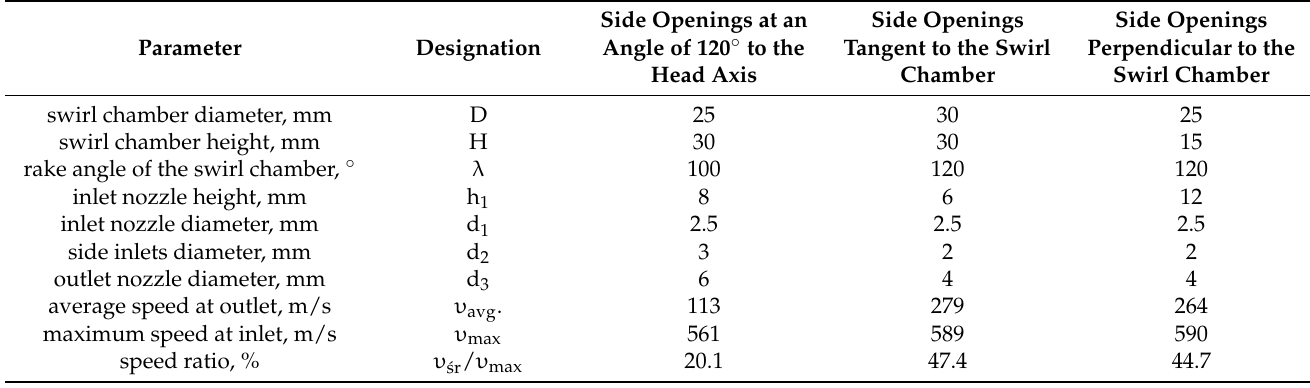
Table 3. Characteristics of the geometric dimensions and velocity of the water stream produced in the heads optimal in terms of the location of the side